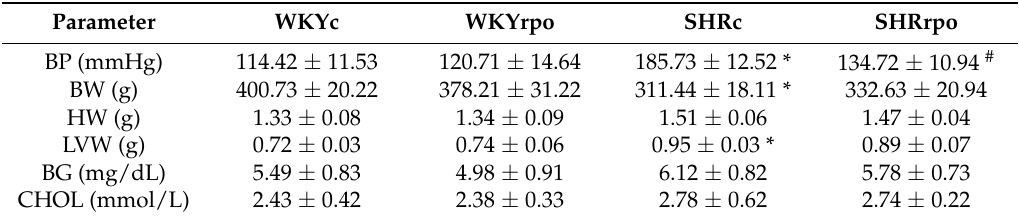
Table 1. General characteristics of the male of normotensive and hypertensive rats without and with red palm oil intake.